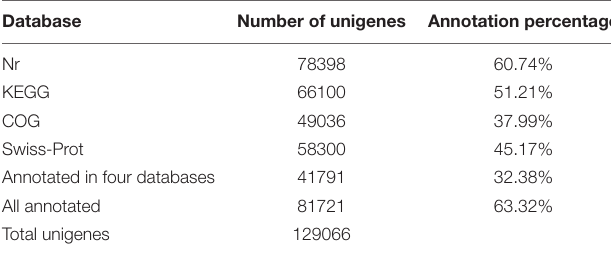
TABLE 1 | Summary of Illumina sequencing and assembly of G.